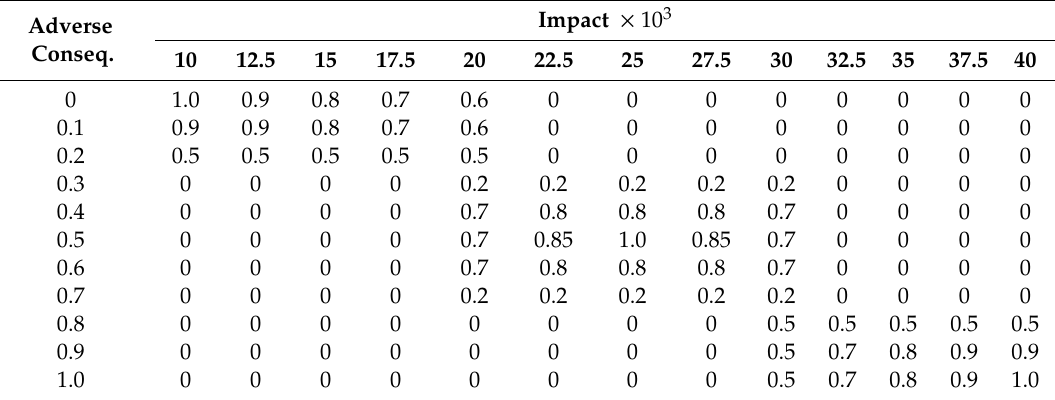
Table 8. Fuzzy union matrix V of all relationships between adverse consequence ( C ) and impact ( I ). Adverse